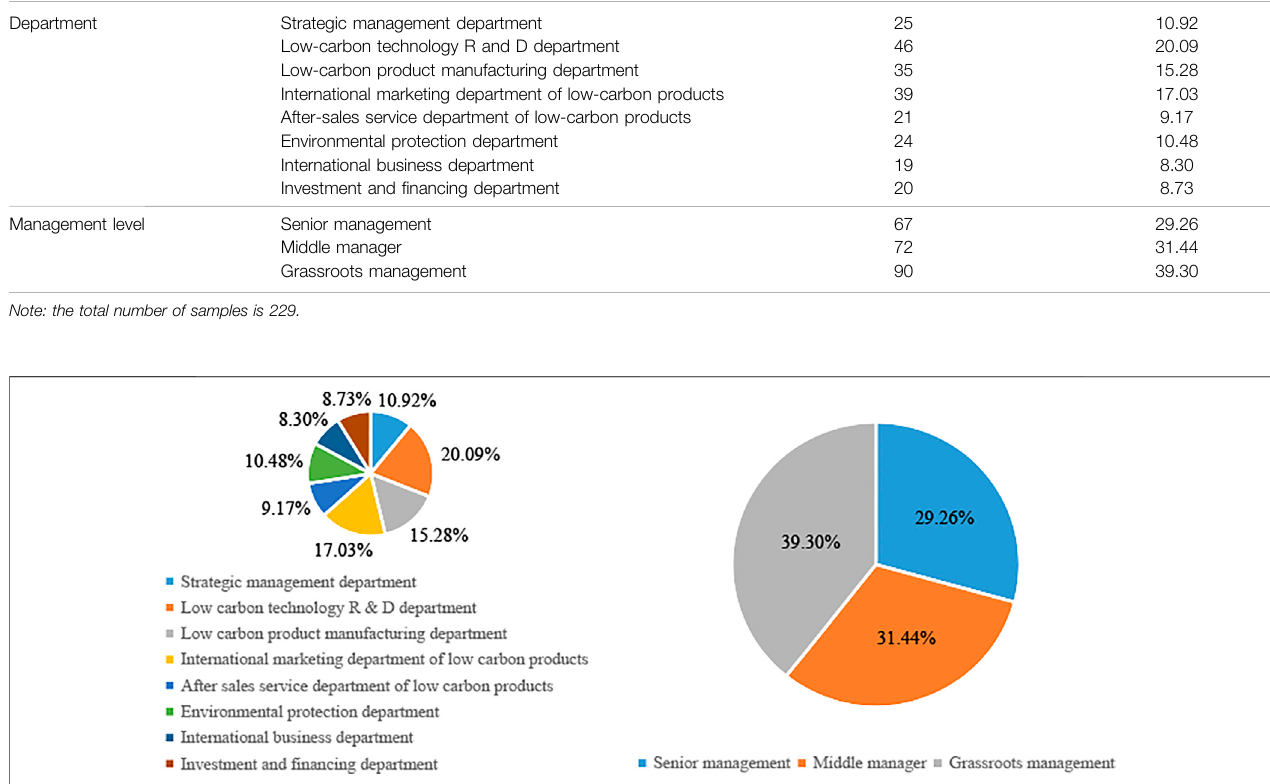
FIGURE 4 | Department source and management level distribution of